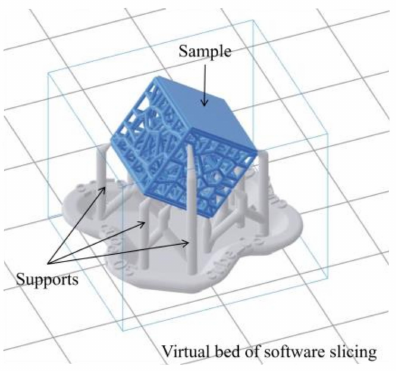
Figure 2. Orientation and supports needed for the SLA